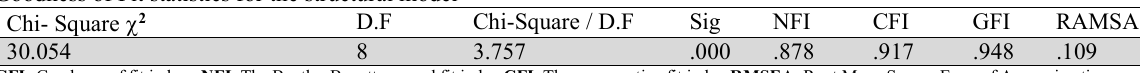
Goodness of Fit statistics for the structural model Chi- Square 